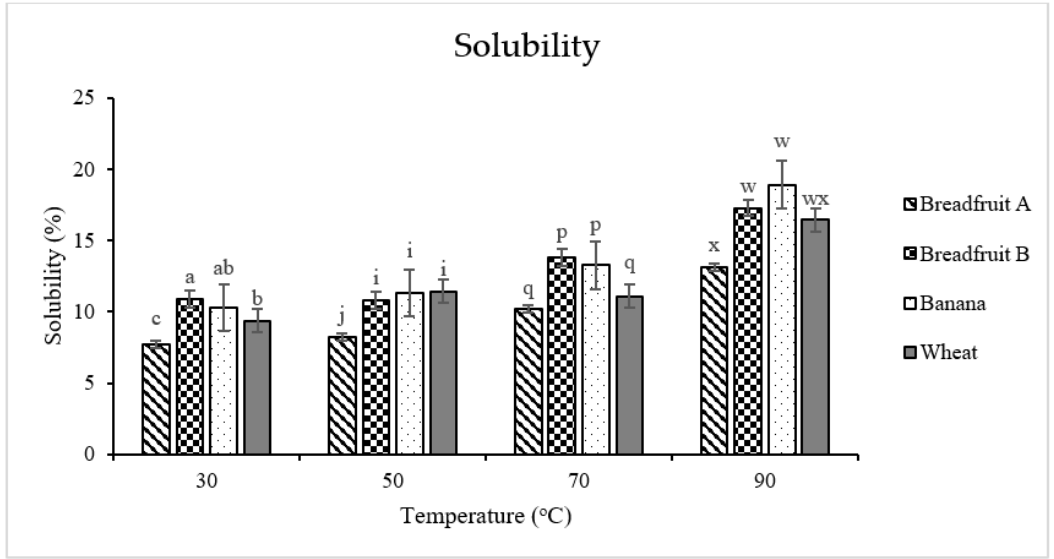
Figure 3. Solubility of tropical flours compared with a traditional flour. Within each temperature, means without a common superscript di ff er ( p ≤ 0.05). Treatments were flour types of breadfruit A, breadfruit B, banana, or wheat. Breadfruit flour A was sourced from Natural Foods International (Apia, Western Samoa). Breadfruit flour B was sourced from Jungle Project (Alajuela, Costa Rica). Banana flour was sourced from LiveKuna, Kunachia LLC (Davie, FL, USA). Wheat flour was obtained commercially from Bulk Barn Foods (Aurora, ON,